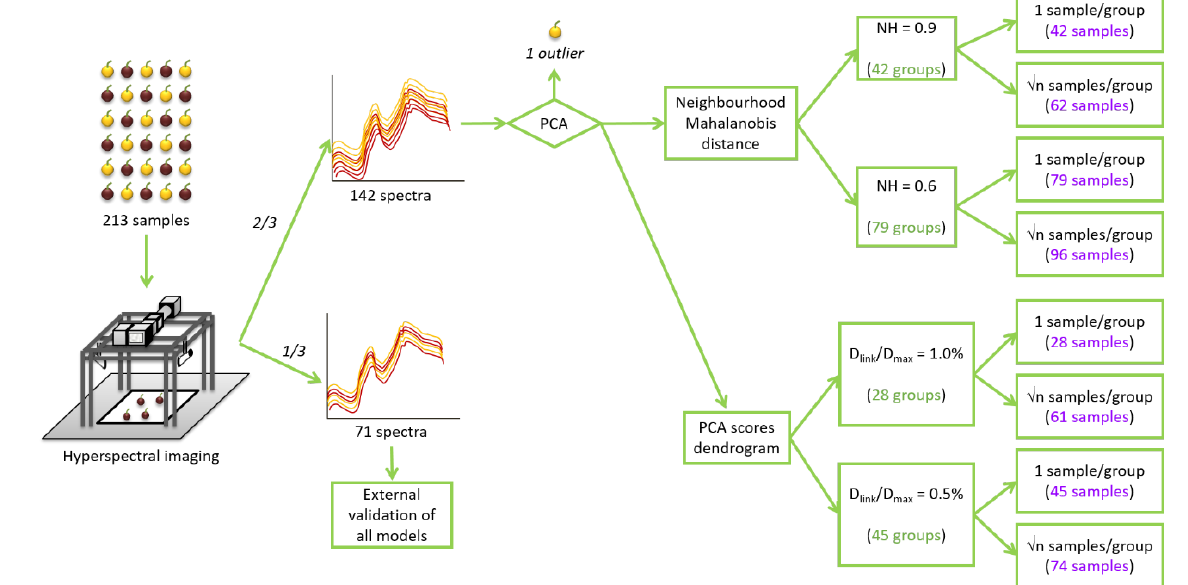
Figure 1. Schematic representation of the spectra acquisition and the sample selection procedure. NH: Neighbourhood Mahalanobis distance; Dlink: different linkage distances; Dmax: the maximum linkage distance.